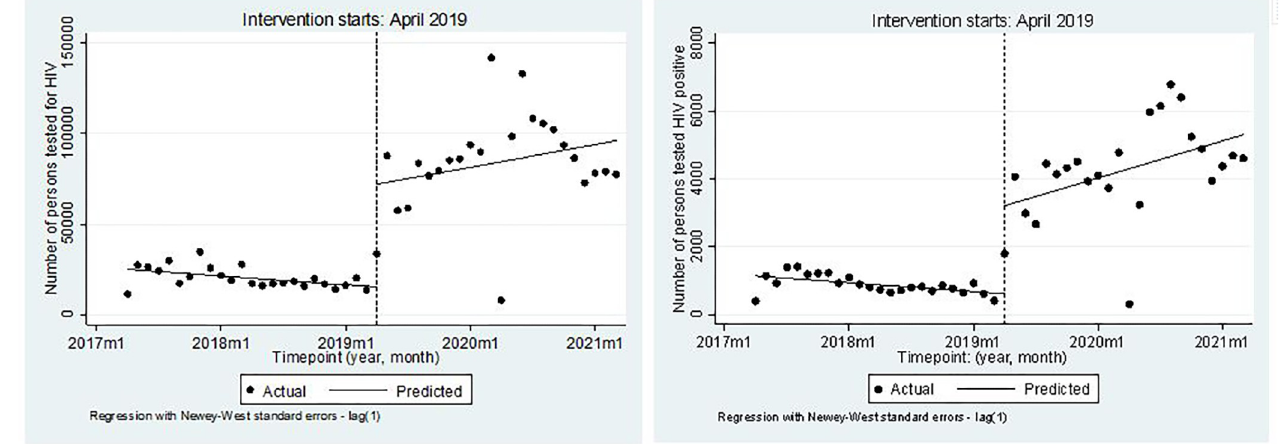
Fig 2. Actual and predicted trends in total number of persons i. tested and ii tested positive, by month, April 2017–March